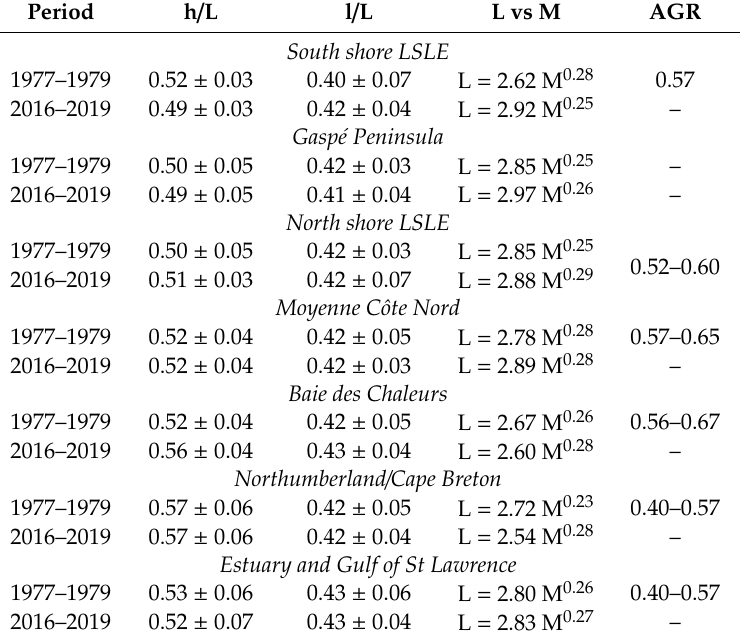
Figure 2. Length-mass relationship of Mytilus edulis shell from six hydro-ecological regions of the St. Lawrence Estuary and Gulf (Figure 1). Mussels sampled in 1977–1979 (n = 1222) and in 2016–2019 (n = 504) periods. Table 1. Allometric relationships in the mussel shell shape and their changes between 1977–1979 and 2016–2019 periods. L: length (cm), l: width (cm); h: height (cm); M: mass (g). All the relationships were statistically significant with a p < 0.001. AGR: Absolute growth rate (cm y − 1 ) from ref. [17]. 1977–1979 statistics were calculated on 1222 individual mussels vs. 504 in